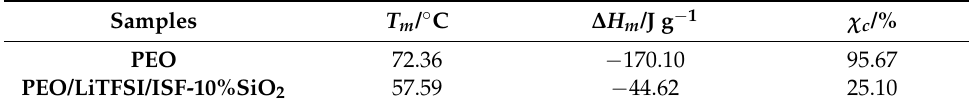
Table 2. The thermal properties value of pristine PEO and PEO/LiTFSI/ISF-10%SiO 2 .